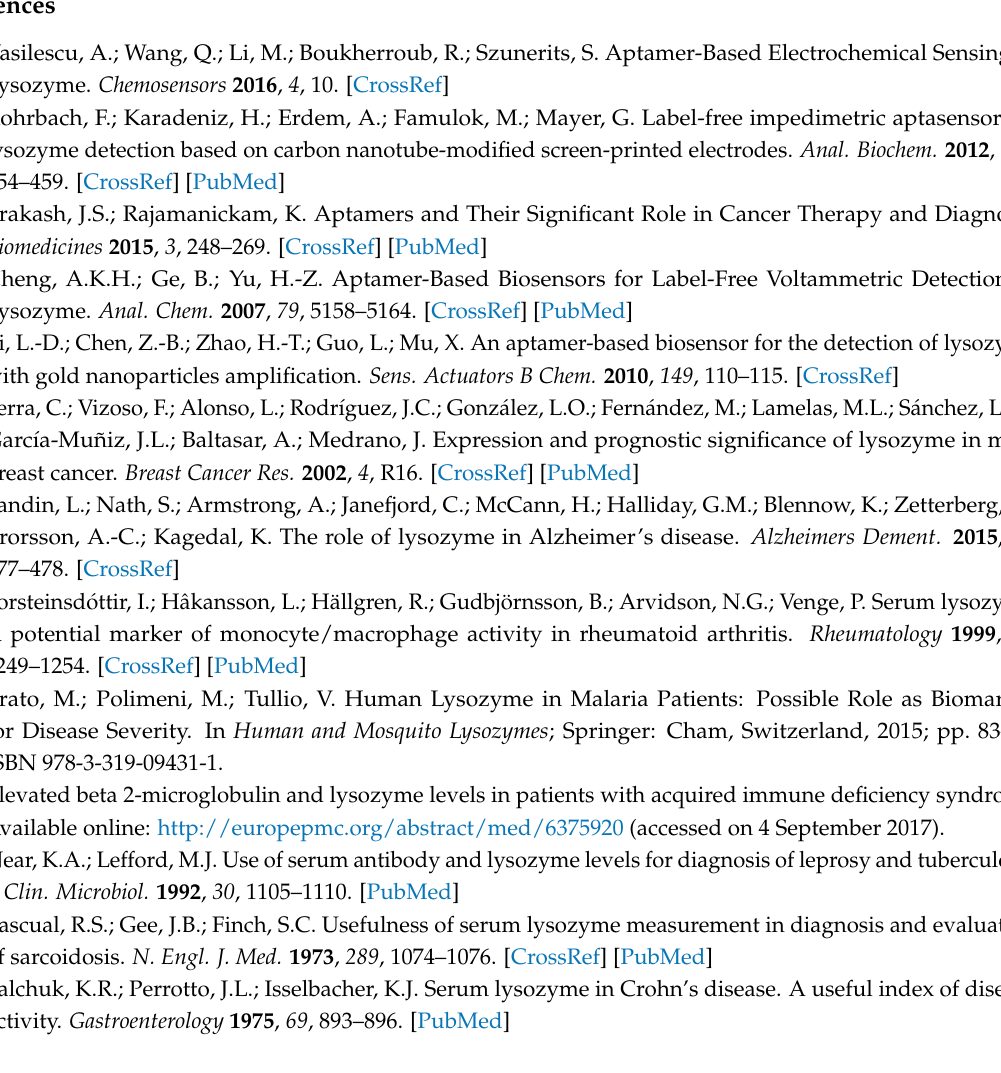
Figure A3. Comparison of the sensor responses as a function of the different printing layers. Each sensor was exposed to 1 µg/mL of lysozyme protein.